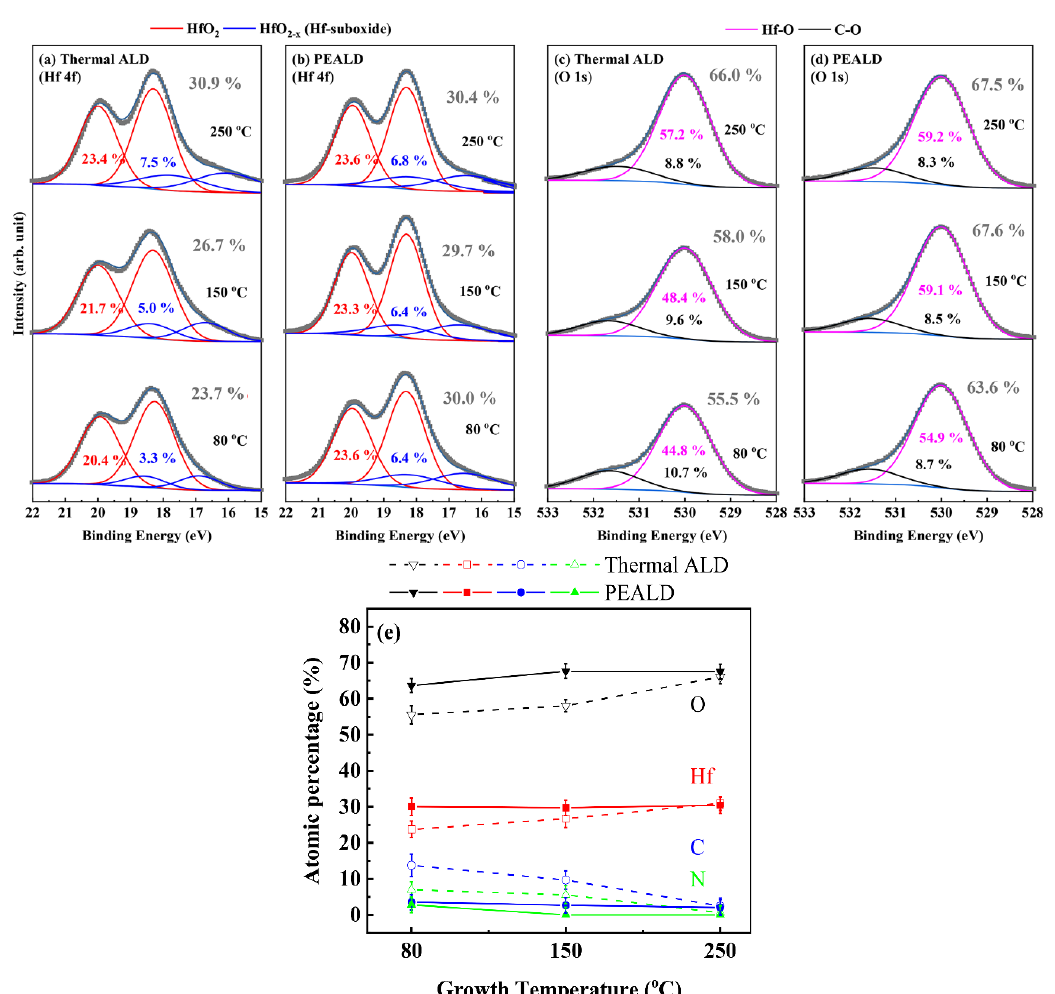
Figure 3. ( a , b ) Hf 4f and ( c , d ) O 1s spectra of HfO 2 thin films (50 nm) on Si substrate fabricated by thermal ALD and PEALD. Gray dotted lines and blue solid lines are sum of the spectra before fitting and sum of the deconvoluted peaks after fitting, respectively. ( e ) Surface component percentages of O, Hf, C and N in HfO 2 thin films (50 nm). The error bars represent the standard deviations. The deconvoluted Hf 4f spectra show the doublet of peaks at binding energy of 18.31 and 19.99 eV, which is associated with HfO 2 [33]. Moreover, at binding energy lower than those of the 4f doublet, the suboxide peaks are located at 16.93 and 18.63 eV, and they are associated with HfO 2 − x . The atomic concentration of hafnium in HfO 2 thin film deposited at a low temperature by thermal ALD was the lowest at 23.7%, because many defects, such as carbon, nitrogen and hydroxyl groups ( − OH), were